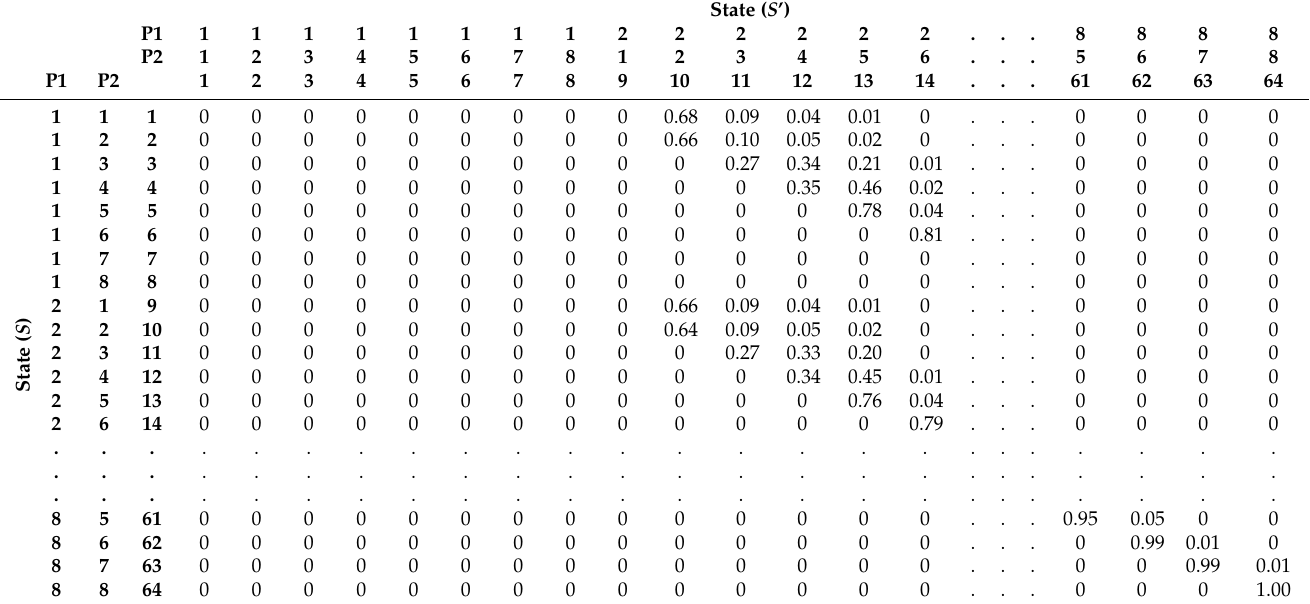
Table 6. Transition probability for a two-pipe system based on pipeline 1 (P1) and pipeline 2 (P2).